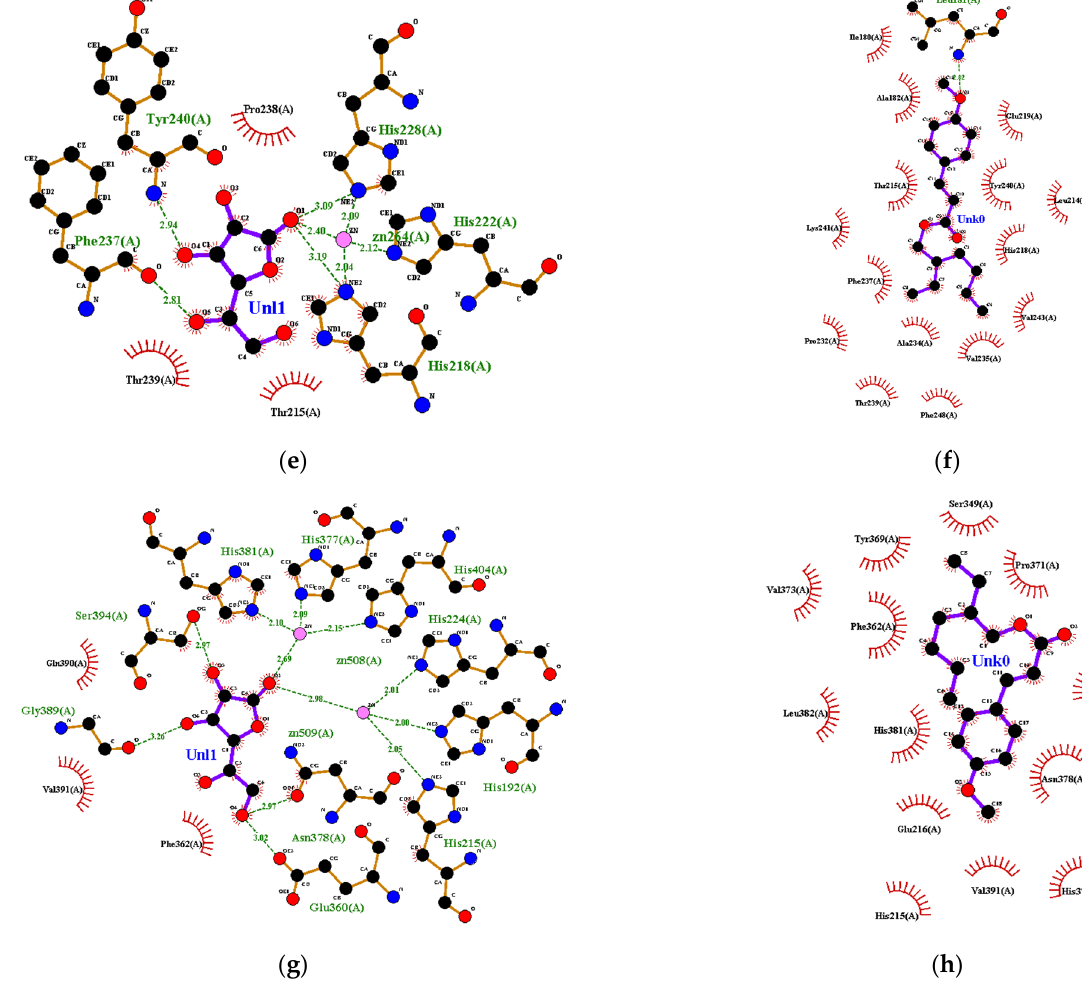
Figure 4. Visualization of the binding of: ( a ) ascorbic acid and ( b ) octinoxate to the collagenase (2TCL); ( c ) ascorbic acid and ( d ) octinoxate to the hyaluronidase (2PE4); ( e ) ascorbic acid and ( f ) octinoxate to the elastase (3F19); and ( g ) ascorbic acid and ( h ) octinoxate to the tyrosinase (5M8R).